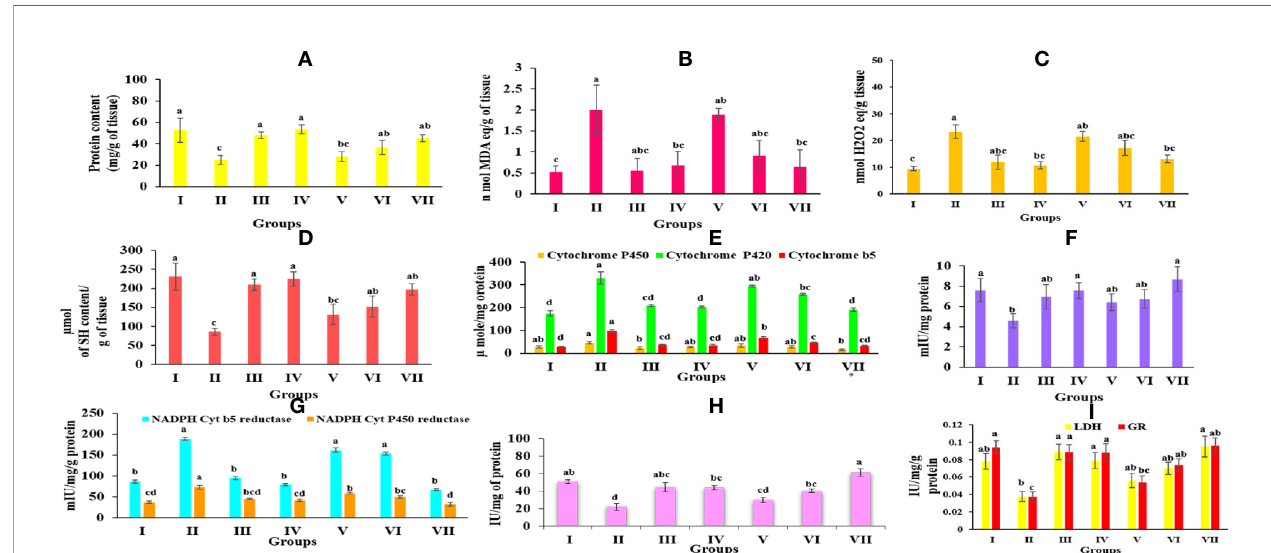
FIGURE 5 | Graph represents the effect of Obeth of O. bracteata on level of enzymes in CCl 4 -treated male Wistar rats. (A) Represent the levels of protein in liver homogenates. (B) Represent the levels of malondialdehyde (MDA) content in liver homogenate. (C) Represent the levels of lipid hyperoxide in liver homogenates. (D) Represent the levels of reduced glutathione (GSH) in liver homogenate. (E) Represent the levels of NADH Cyt b5 and NADH Cyt P 450 in liver homogenate of Wistar rats. (F) Represent the levels of GST in liver homogenate of Wistar rats. (G) Represent the levels of NADH Cyt b5 and NADH Cyt P 450 in liver homogenate of Wistar rats. (H) Represent the levels of Catalase in liver homogenate. (I) Represent the levels of lactate dehydrogenase and glutathione reductase in liver homogenate. Values are expressed as Mean ± SE at level of signi fi cance p ≤ 0.05. Data labels with different letters represent signi fi cant difference among